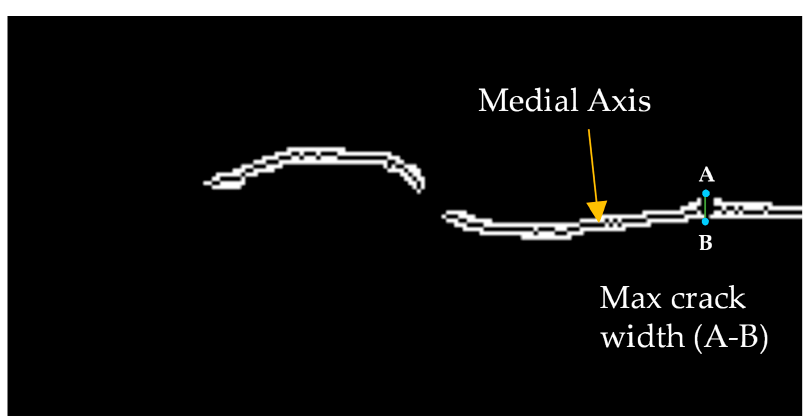
Figure 4. Calculation of maximum crack width based on medial axis.